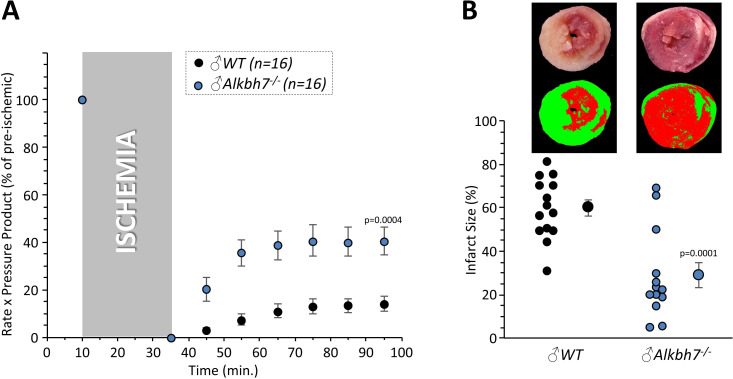
Response to ex-vivo cardiac ischemia-reperfusion (IR) injury in WT vs.Alkbh7-/-.Hearts from young male WT and Alkbh7-/- mice were Langendorff perfused and subjected to 25 min ischemia plus 60 min reperfusion. (A) Cardiac function assessed by left ventricular balloon pressure transducer. Graph shows the product of heart rate multiplied by left ventricular developed pressure, as a percentage of the initial (pre-ischemic) value. (B) Post IR staining with TTC for quantitation of myocardial infarct size. Representative TTC-stained heart slices are shown, with pseudo-colored mask images used for quantitation by planimetry (red = live tissue, green = infarct). Data are quantified below, with individual data points to shown N, and means ± SE. p-values (paired t-test) are shown above error bars.